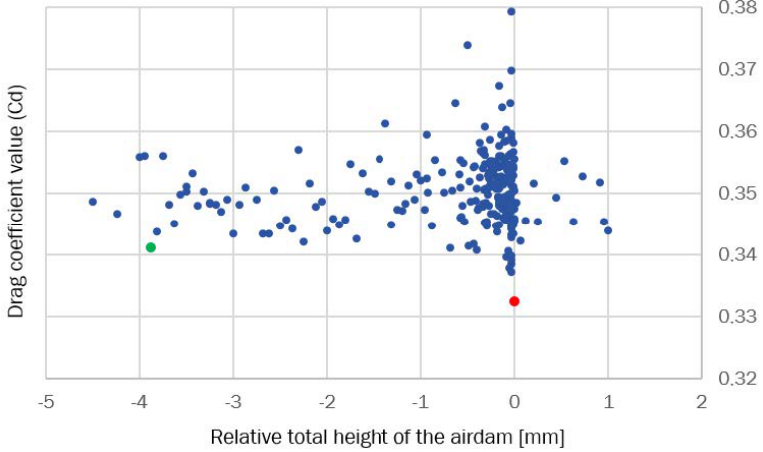
Figure 15. Cd objective versus the total height of the air dam. Red point corresponds to the reference air dam configuration (not practical for reasons of style and reliability), green point to the minimum air dam height geometry (acceptable without too heavy losses in performance).